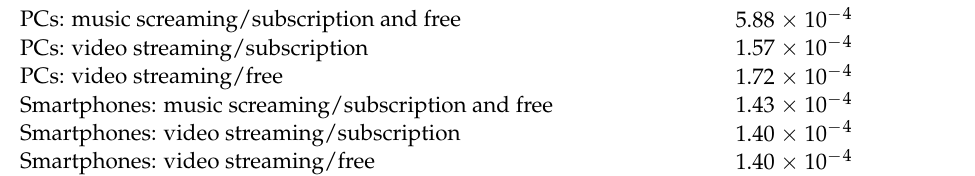
Table 6. Life cycle CO 2